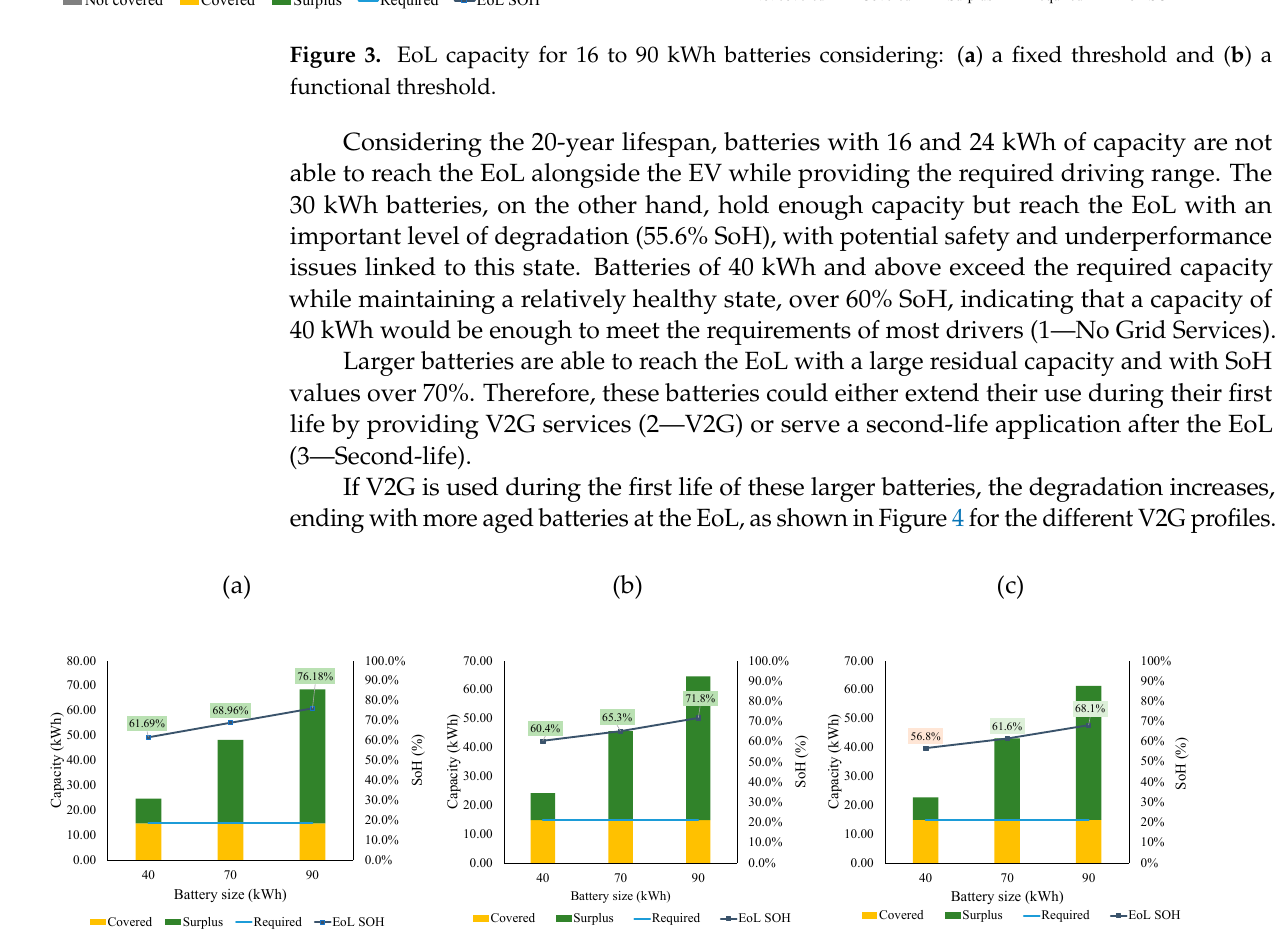
Figure 4. EoL capacity for 40, 70, and 90 kWh batteries considering V2G services: ( a ) residential, ( b ) peak shaving and ( c ) demand response.